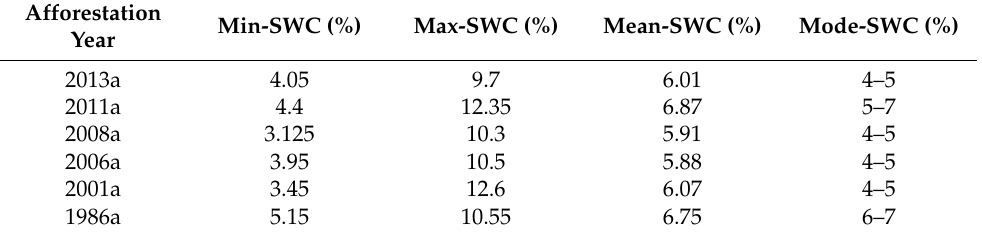
Table 7. Characteristics of